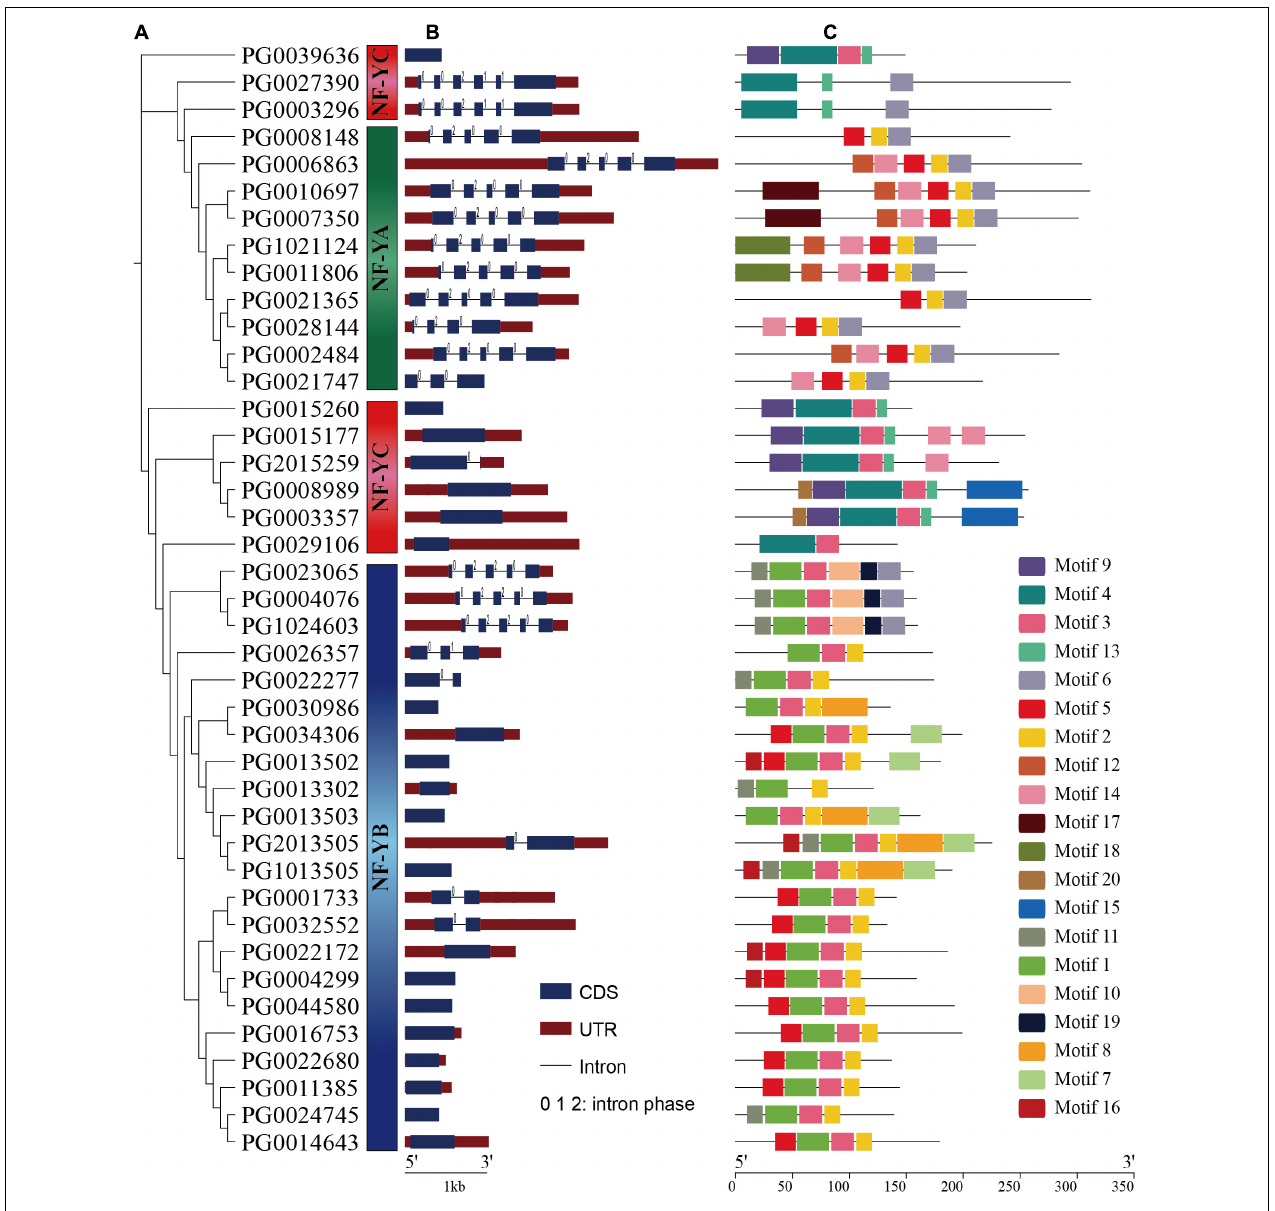
FIGURE 5 | Phylogenetic relationships, gene structure, and conserved motifs analysis of StNF-Ys. (A) Phylogenetic tree of StNF-Ys. (B) Exon/intron organization of the StNF-Y genes. The blue box indicates the exon, and the black line of the same length indicates the intron. The upstream/downstream area is indicated by a red box. The numbers 0, 1, and 2 represent the splicing phase of the intron. (C) Distribution of conserved motifs in StNF-Ys. The putative motifs were predicted by MEME program. The 20 boxes of different colors represent 20 different putative motifs. The details of the 20 putative motifs are in Supplementary Table 3